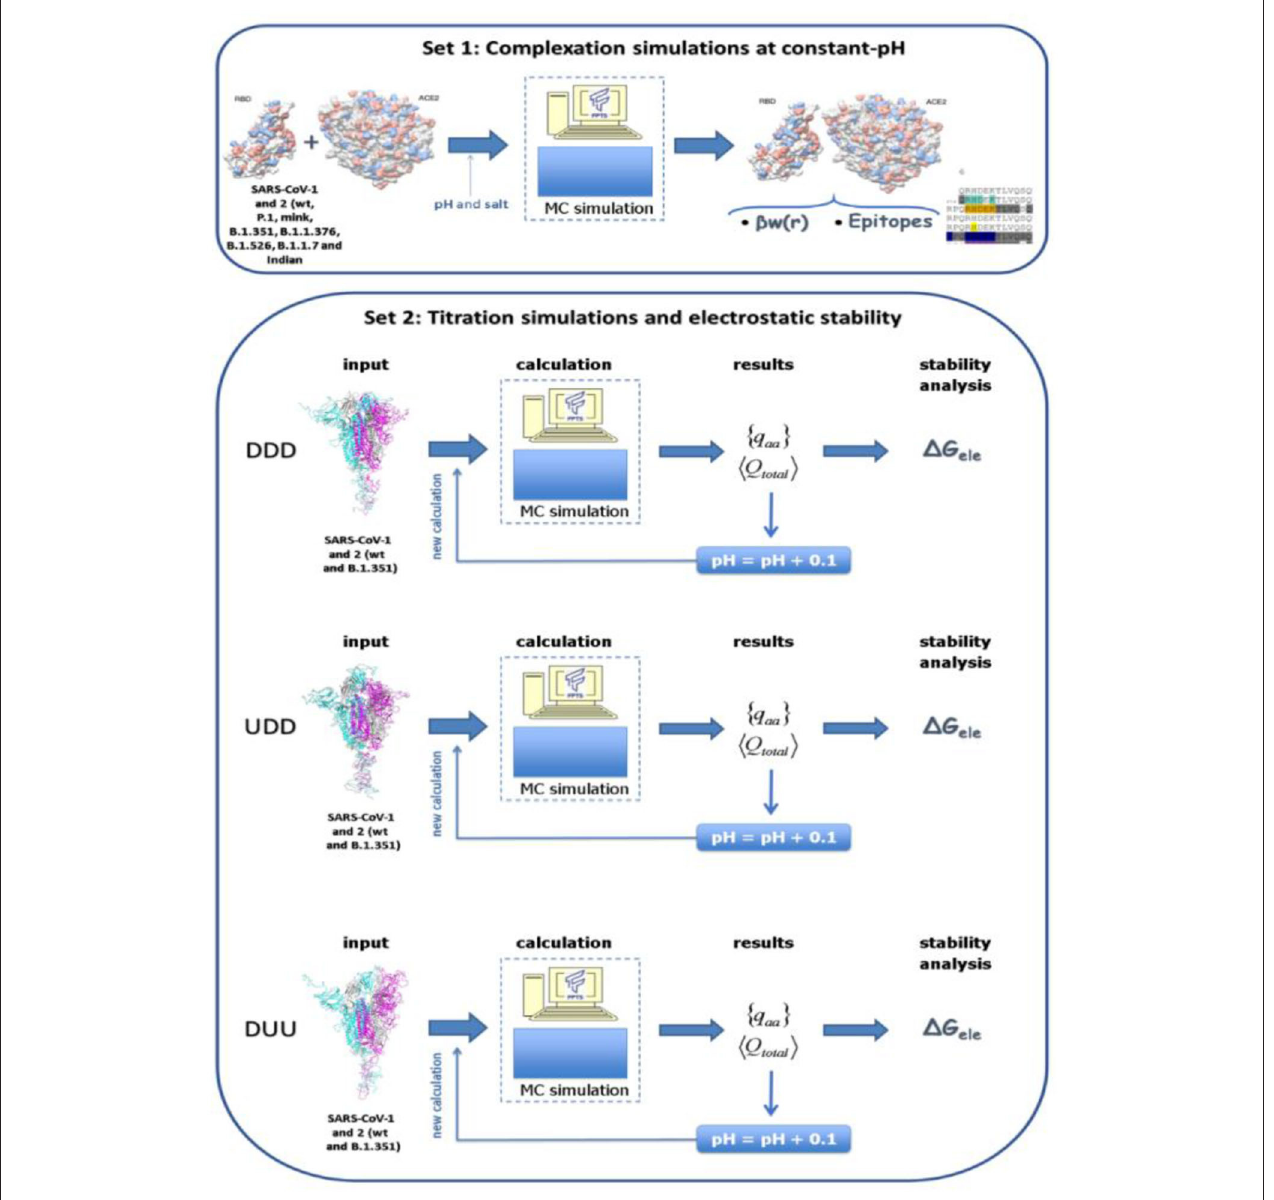
FIGURE 1 | Schematic representation for the two simulation sets of this study. Simulation set 1 represents complexation simulations at constant-pH where the interaction between the S receptor-binding domain (RBD) protein of SARS-CoV-1, 2 and the the new variants (B.1.351, P.1, and the mink variant) with the human receptor angiotensin-converting enzyme II (ACE2) were investigated. Simulation set 2 represents simulations used to estimate the electrostatic stability of whole spike homotrimeric proteins at different conformational states (DDD, UDD, and DUU, respectively) for all solution pHs. Spike wt proteins from SARS-CoV-1, 2 and its B.1.351 (Beta WHO new label) were